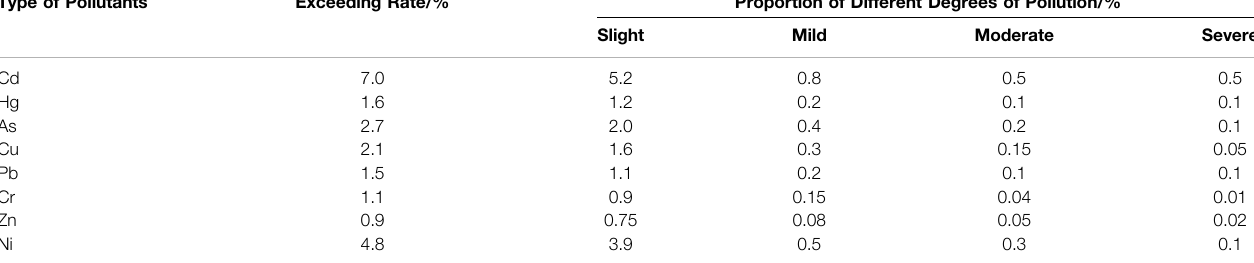
TABLE 1 | Excessive situation of inorganic pollutants of soil in China.